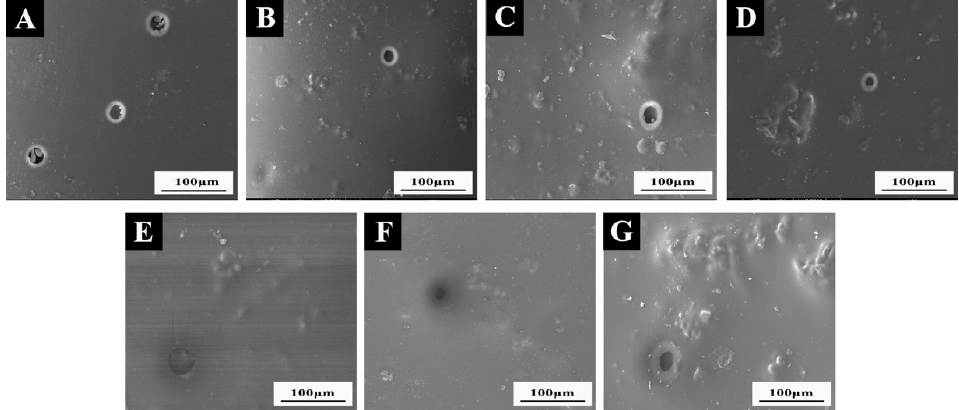
Figure 6. SEM of coatings with different shellac microcapsules after aging: ( A ) 0 microcapsules; ( B ) 3.0 wt.% transparent shellac microcapsules; ( C ) 6.0 wt.% transparent shellac microcapsules; ( D ) 3.0 wt.% transparent purple microcapsules; ( E ) 6.0 wt.% purple shellac microcapsules; ( F ) 3.0 wt.% yellow shellac microcapsules; ( G ) 6.0 wt.% yellow shellac microcapsules. Figure 7 indicates the infrared spectrum of surface coatings on Beli wood without microcapsules and with 3.0 wt.% transparent shellac microcapsules before and after aging. The infrared spectra of surface coatings on Beli wood with 3.0 wt.% purple shellac micro- capsules and yellow shellac microcapsules before and after aging are shown in Figure